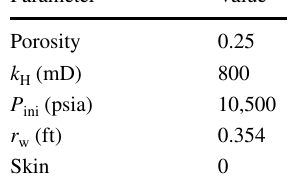
Fig. 2 Error vs. distance from wellbore for two cases: 150 cells